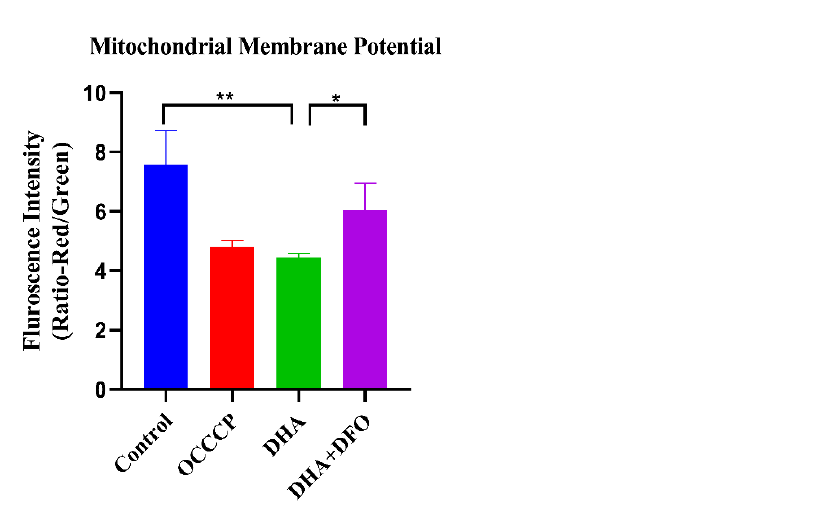
Figure 3. DHA treatment reduces mitochondrial membrane potential. Freshly released tachyzoites were treated with 4 × EC50 (0.88 μM) DHA or DHA + 80 μM DFO at 37 °C for 4 h. The FI signals of the mitochondrial membrane potential fluorescent probe JC-10 were then detected. Quantification of the red/green fluorescence intensity ratio was calculated by comparing the red and green channels per 10 5 tachyzoites. OCCCP was treated as a positive control. Student’s t -tests were used to determine statistical significance (** p < 0.01, and * p < 0.05).